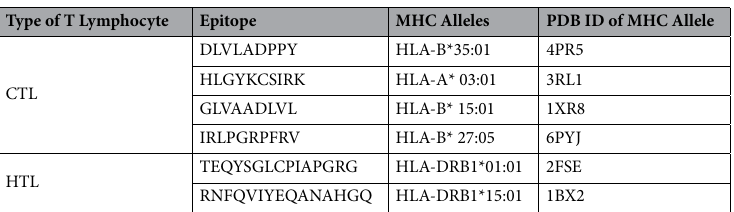
Table 3. Docking analysis of some CTL and HTL epitopes with their corresponding MHC